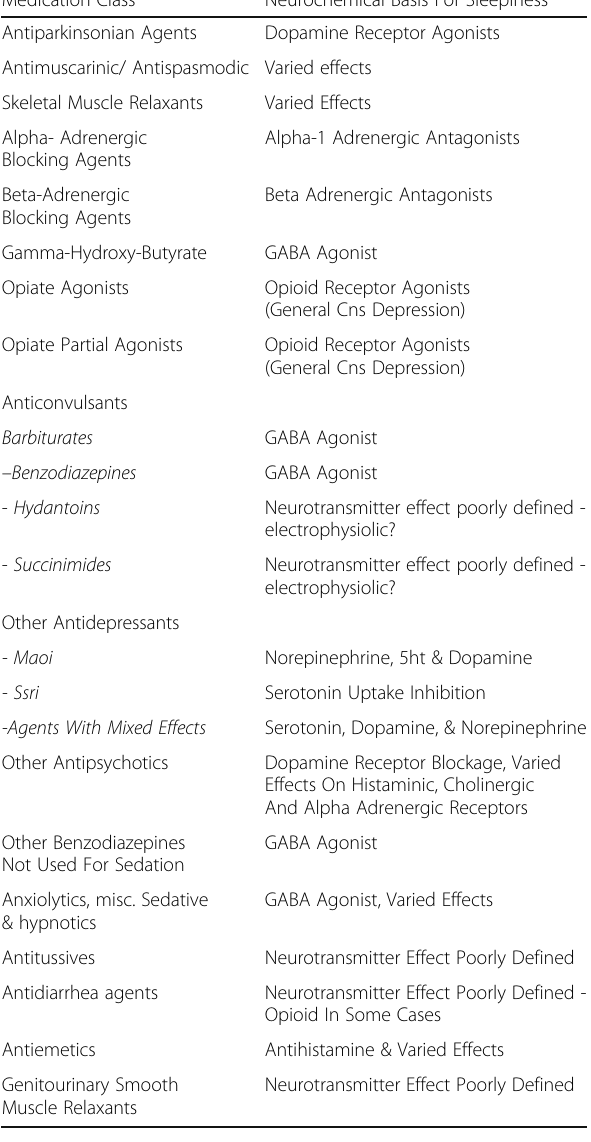
Table 1 Medications Not Classified As